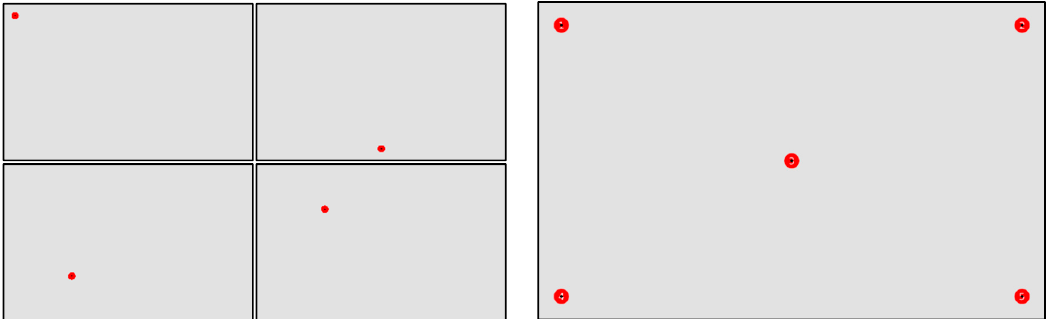
Figure 4. Example of targets’ locations.